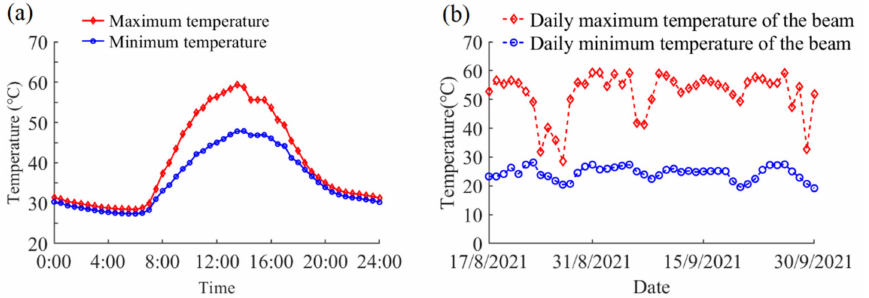
Figure 8. The daily maximum and minimum temperatures of the experimental steel beam: ( a ) on the typical day; ( b ) during the complete experiment